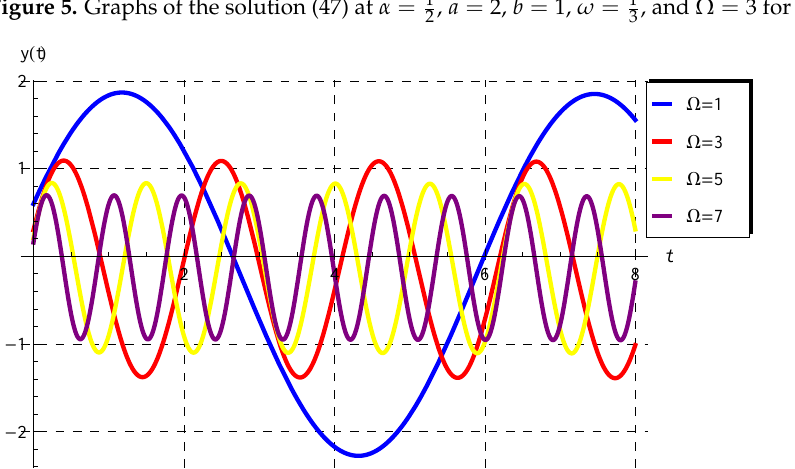
Figure 5. Graphs of the solution (47) at α = 1